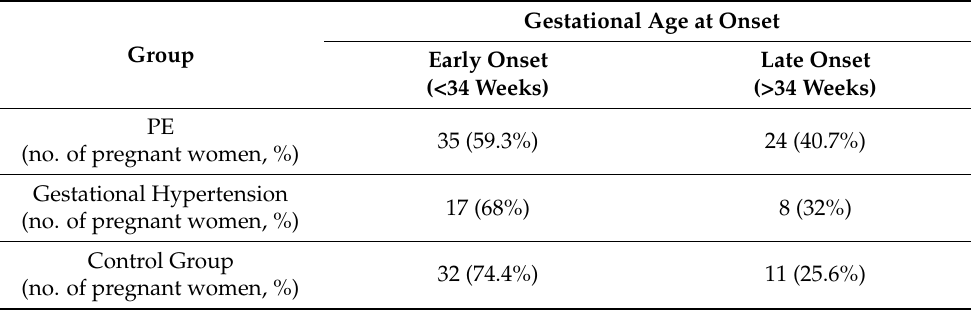
Table 4. Pregnant women distribution according to gestational age at onset.